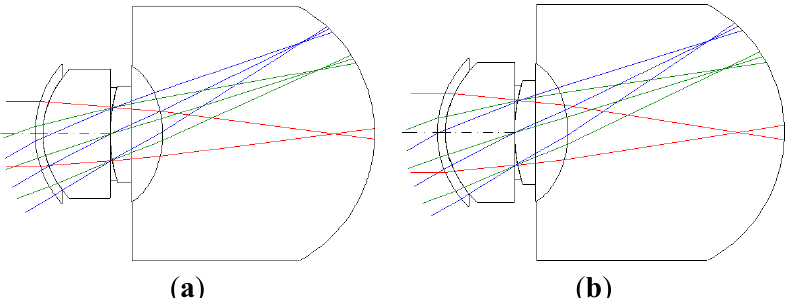
Figure 4. The 2D layout illustrating 550 degrees myopia and 175 degrees astigmatism. ( a ) 5 mm; ( b ) 6 mm.